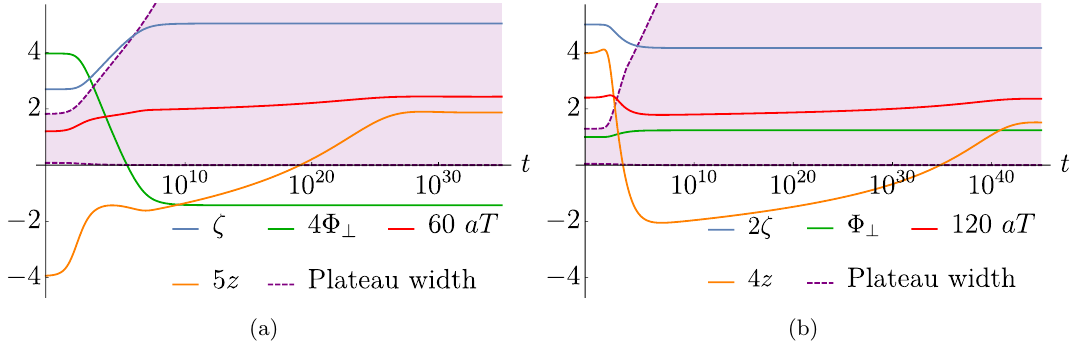
Figure 3 . (a) Numerical simulation of (cid:16) ( t ), z ( t ), (cid:8) ? ( t ) and a ( t ) T ( t ), when (cid:16) sits initially in the decreasing exponential part of its potential (see (cid:12)gures 1 and 2). The purple dashed curve shows the width of the plateau which increases with time. (cid:16) ( t ) begins by increasing while falling along the potential until it is caught by the growing plateau. It then stabilizes while z ( t ), (cid:8) ? ( t ) and a ( t ) T ( t ) eventually reach their asymptotic values. (b) Same simulation when the exponential region of the thermal potential increases with (cid:16) , at initial time. (cid:16) ( t ) begins by decreasing, thus approaching the plateau where it eventually